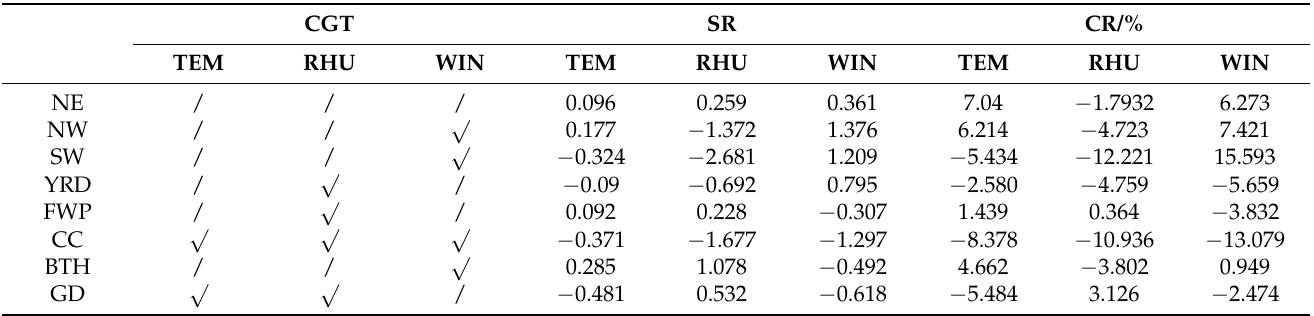
Table 4. Driving force analysis performed on a regional scale between AOD and meteorological factors of major regions.